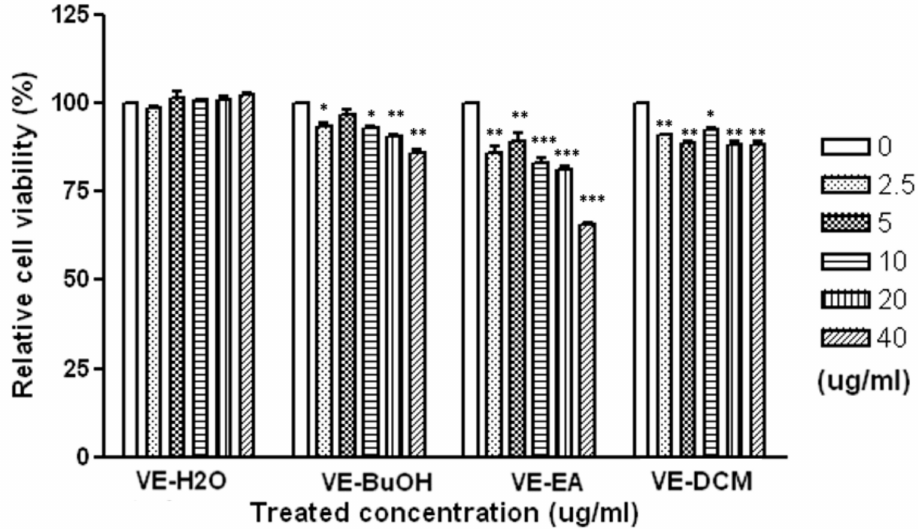
Figure 2. The anti-proliferative activity of different fractions from V. emarginatum on human hepatocellular carcinoma cells (HepG2 cell line). The HepG2 cells were treated with a different concentration from 0 to 40 ug/mL of DCM (dichloromethane), EA (ethyl acetate), BuOH (n-butanol), and water fractions of V. emarginatum . * p < 0.05; ** p < 0.01; *** p <